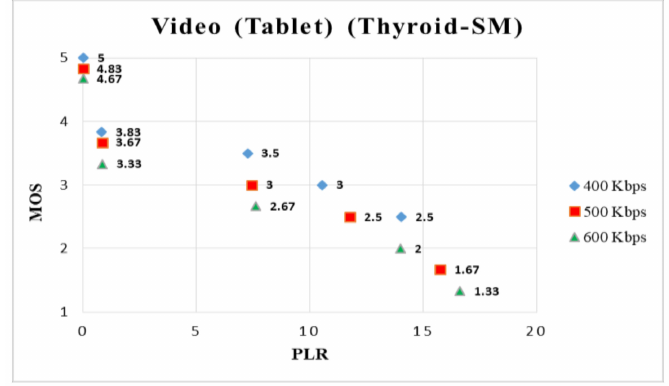
Figure 6. MOS ratings for thyroid ultrasound (SM) on tablet.